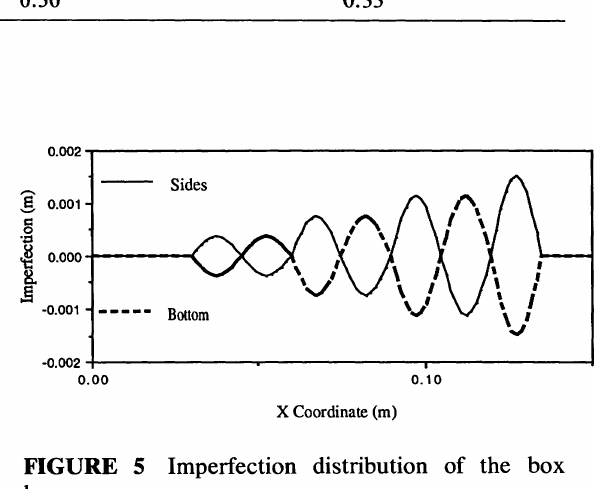
FIGURE 5 Imperfection distribution of the box beam.